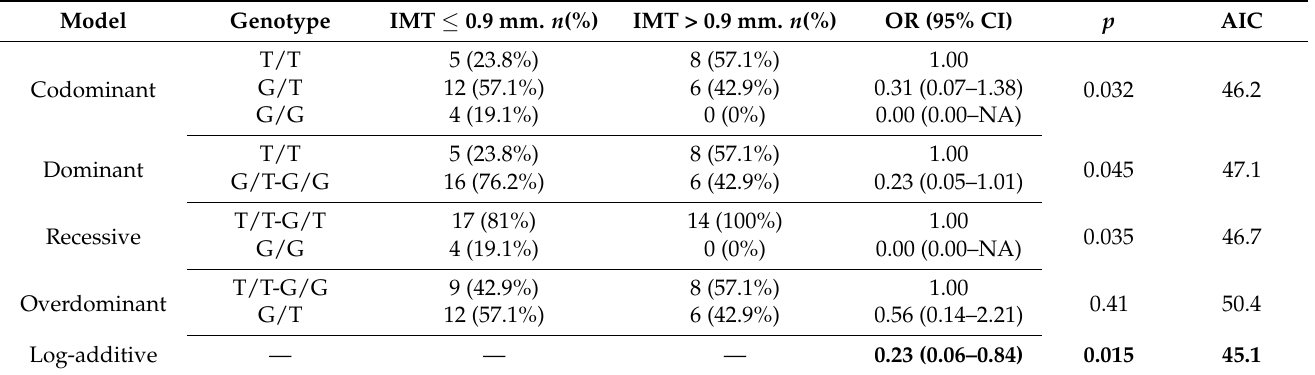
Table 3. Association between rs12444338 and the presence of thick intima-media.